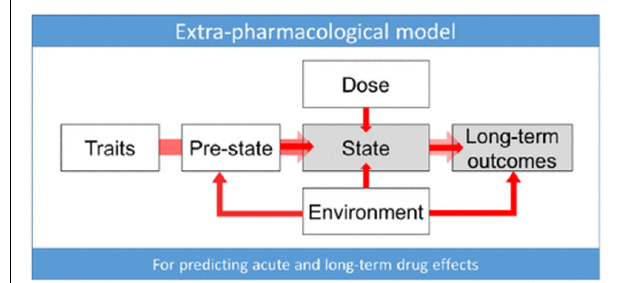
FIGURE 1 | ‘Extra-pharmacological’ factors that can determine psychedelic drug effects (Carhart-Harris and Nutt, 2017). “ Trait factors may be biological [e.g., receptor polymorphisms (Ott, 2007)] or psychological in nature [e.g., personality (MacLean et al., 2011) or suggestibility (Carhart-Harris et al., 2015)]. The pre-state refers to such things as anticipatory anxiety, expectations and assumptions (which account for so-called ‘placebo’ and ‘nocebo’ effects), and readiness to surrender resistances and ‘let go’ to the drug effects (e.g., see Russ and Elliott, 2017). In the context of psychedelic research, the pre-state is traditionally referred to as the ‘set’ (Hartogsohn, 2016). State refers to the acute subjective and biological quality of the drug experience and may be measured via subjective rating scales or brain imaging (see Roseman et al., 2017). Dose relates to the drug dosage—which may be a critical determinant of state (Griffiths et al., 2011; Nour et al., 2016)—as well as long-term outcomes (see Roseman et al., 2017). Environment relates to the various environmental influences. In the context of psychedelic research this is traditionally referred to as ‘setting’ (Hartogsohn, 2016). We recognize that the environment can be influential at all stages of the process of change associated with drug action. The long-term outcomes may include such things as symptoms of a specific psychiatric condition such as depression—measured using a standard rating scale (Carhart-Harris et al., 2016a) as well as relatively pathology-independent factors such as personality (MacLean et al., 2011) and outlook” (Carhart-Harris and Nutt, 2017, p.